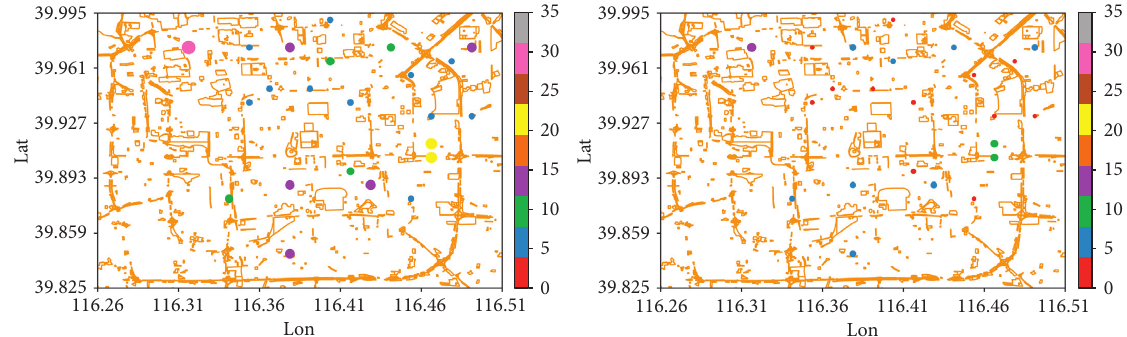
Figure 14: Parking spots and vehicle distribution when rate � 0.6.